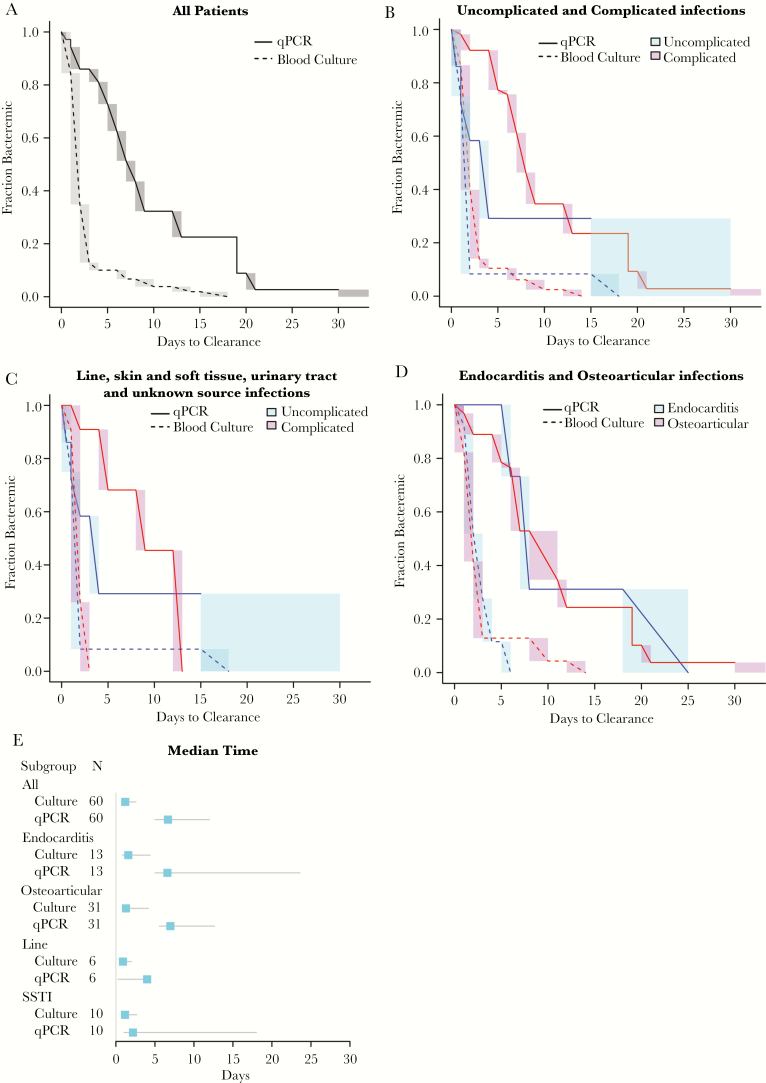
Comparison between the duration of circulating Staphylococcus aureus deoxyribonucleic acid (SA-DNA) levels and duration of blood culture (BC) positivity. (A) Time to clearance of S aureus by BC (dotted lines) and SA-DNA (solid lines) by quantitative polymerase chain reaction (qPCR) in all patients. (B) Time to clearance of S aureus by BC (dotted lines) and SA-DNA (solid lines) in uncomplicated versus complicated infections. (C) Time to clearance of S aureus by BC and SA-DNA of catheter, skin and soft tissue infection (SSTI), urinary tract infection, and unknown infection source categorized into uncomplicated and complicated infections. (D) Time to clearance of S aureus by BC and SA-DNA in osteoarticular and endocarditis infections. Shading indicates the uncertainty in the interval censored data. (E) Comparison of the median time to clearance of S aureus as measured by BC (1.3 days) and SA-DNA by qPCR (6.3 days) in all subjects and subdivided by source of infection. Lines represent a 95% confidence interval around the median.